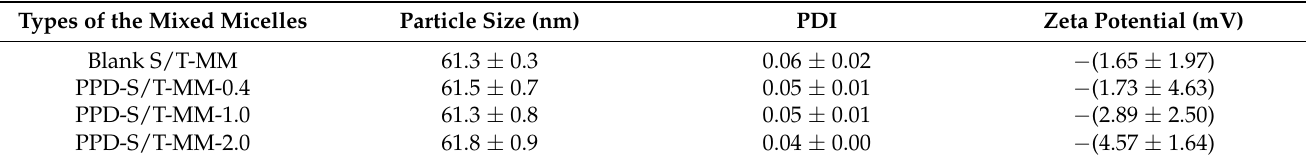
Table 2. Particle size, PDI and zeta potential of blank S/T-MM and PPD-S/T-MM (Mean ± SD, n = 3).